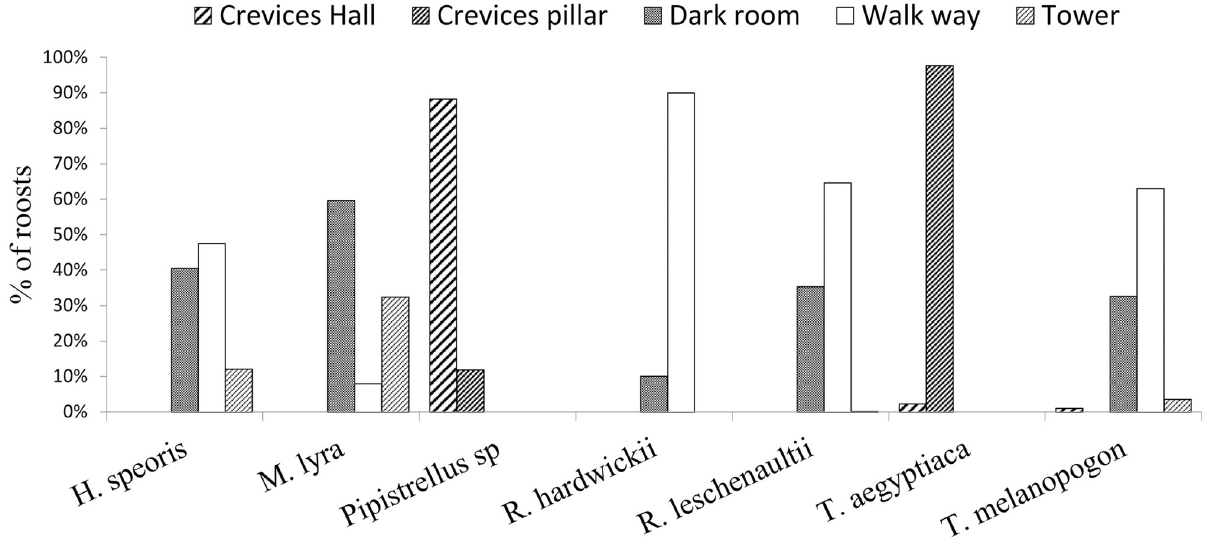
Fig 1. Percentage of microhabitats used by the different species of bats for